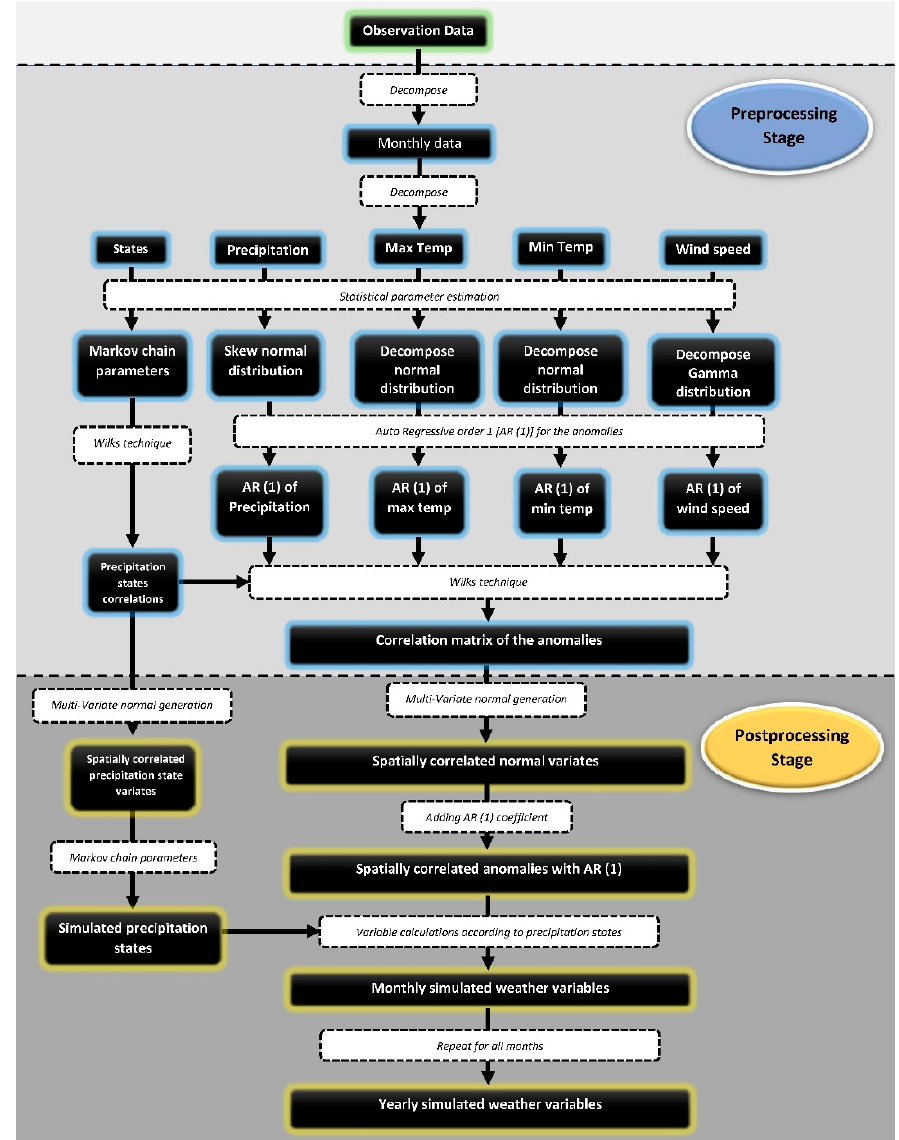
Figure 1. Schematic flowchart of the daily weather generation processes.